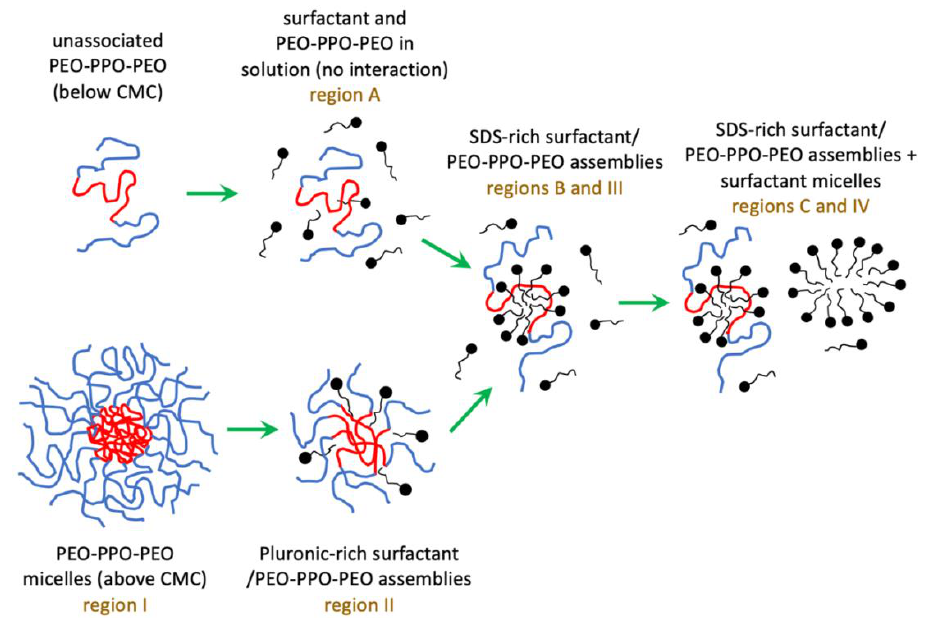
Figure 6. Different modes of PEO-PPO-PEO block copolymer and ionic surfactant interactions in aqueous solution when an increasing amount of ionic surfactant is added to polymer solutions of fixed concentration (below or above the block copolymer CMC in plain water).